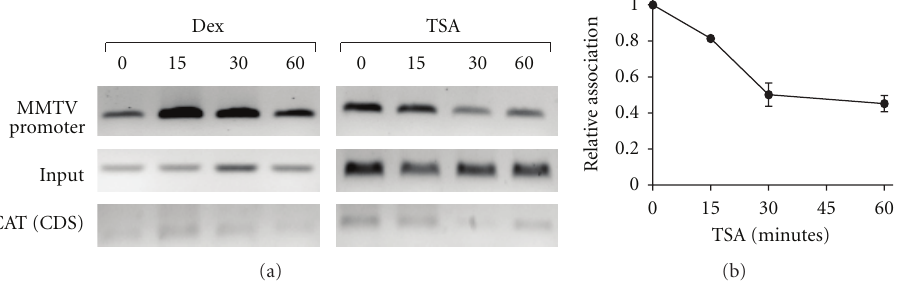
Figure 3: Inhibition of HDACs results in the lossof initiating RNA pol II from the MMTV promoter. 1470.2 cells were treated with either Dex (100nM) or TSA (50ng/ml) for 0, 15, 30, or 60 minutes, after which cells were processed for ChIP assay.Chromatin was immunoprecipitated with an RNA pol II antibody that recognizes the hypophosphorylated form of the CTD. Conventional PCR was performed on input and immunoprecipitated DNA using primers specific for the MMTV promoter and the coding region (CDS) of the CAT reporter. PCR results from a representative experiment are shown in (a). A graphical representation of the data from 2 to 3 independent experiments is shown in (b) for the TSA time course. Values from control samples were set to 1, and values from TSA-treated samples are expressed as a fraction. Error bars represent